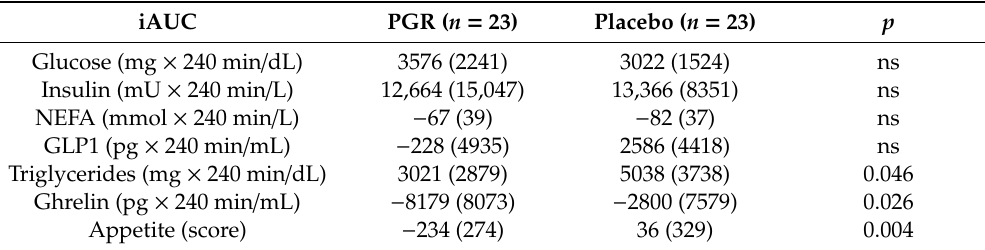
Table 2. iAUCs of glucose, insulin, NEFA, GLP1, triglycerides, Ghrelin and